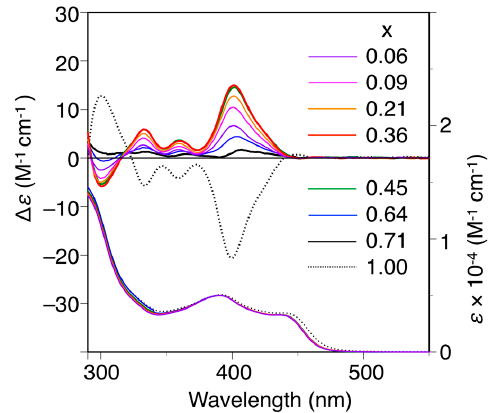
Figure 3. CD and absorption spectra of poly-( 2 S x - co - 3 1–x ) and h -poly- 2 S in DMF at 25 °C. h -poly-( 2 S x - co - 3 1–x ) and h -poly- 2 were obtained by annealing poly-( 2 S x - co - 3 1–x ) and poly- 2 S , respectively, in DMF at 120 °C for 2 h.